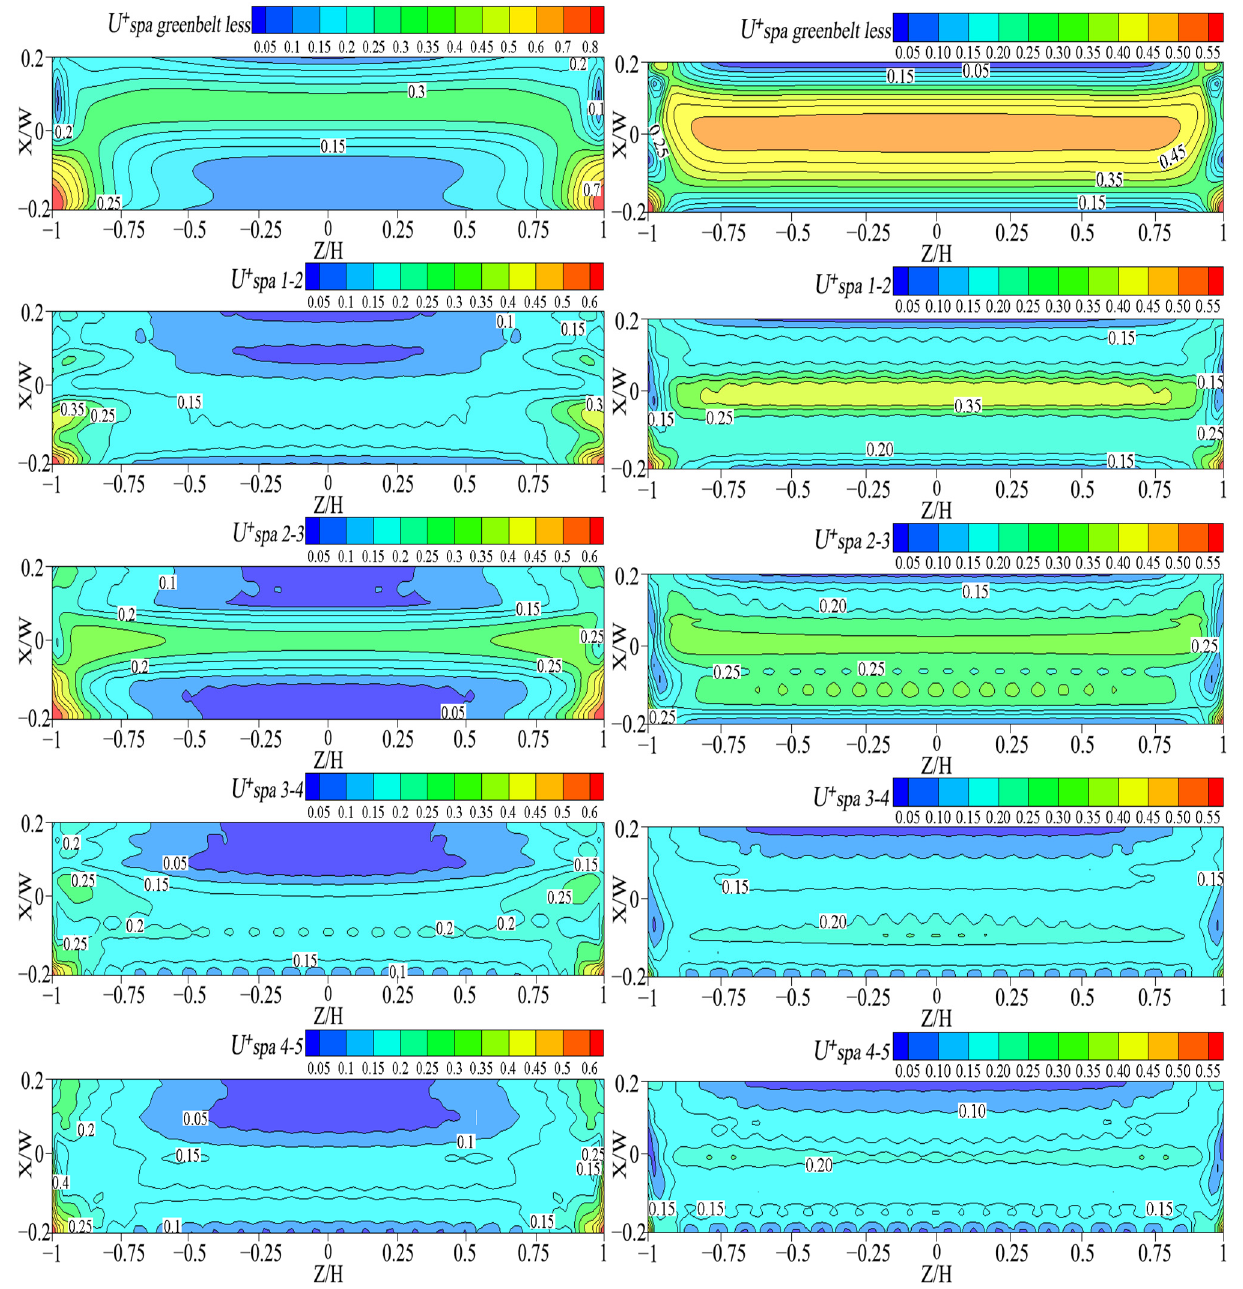
Figure 13. The normalized flow velocity diagram U+ at the breathing height of people in different green-belt scenarios, in an ASF = 1/3 ( left ) and 2/3 ( right ) step-up street. When ASF = 2/3 (on the right side of the figure), the velocity trend on the leeward side and the windward side is consistent with that of the scheme with ASF = 1/3, but there are additional low-velocity areas at both ends of the street canyon. The velocity in the middle of the street canyon is generally higher than that in other locations. The specific performance is as follows: (1) the maximum flow velocity area is located near the two ends and the middle of the windward side of the street canyon. The distribution range of the normalized flow velocity of 0.20–0.55 is the largest in Spa2-3, where the windward side gradually decreases with the increase in the green belt. (2) The minimum flow velocity area is located on the leeward side (Z/H = ± 1, X/W = 0.2) and near both ends, while the distribution range of normalized flow velocity ≤ 0.1 increases with the green belt. While